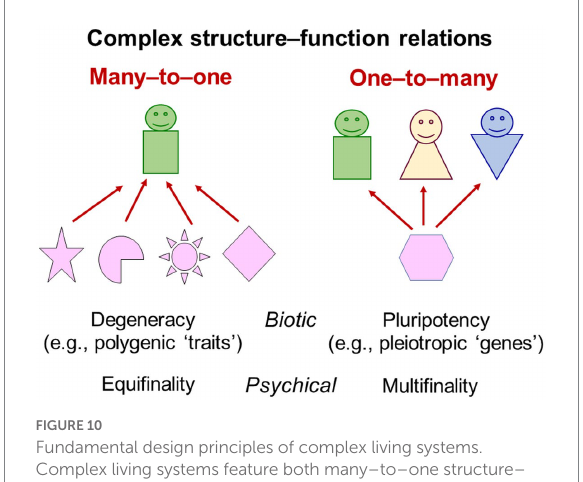
FIGURE 10 Fundamental design principles of complex living